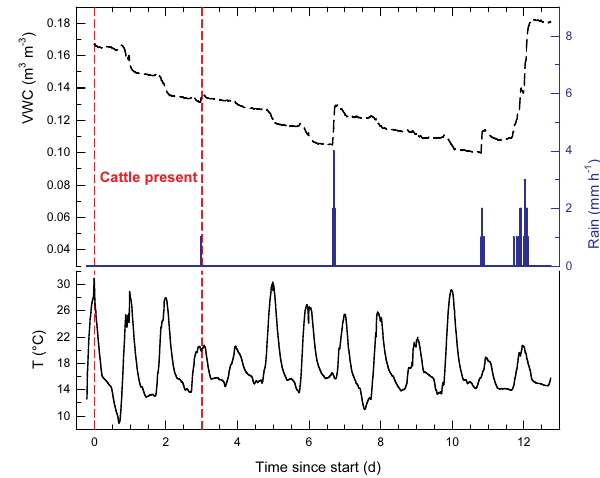
Fig. 1. Temporal evolution of volumetric water content (top) and soil temperature (bottom) at 2cm depth, as well as rainfall intensity (centre). The origin of the time axis is at 16:05LT on 8 March 2011, when the cattle entered the circular